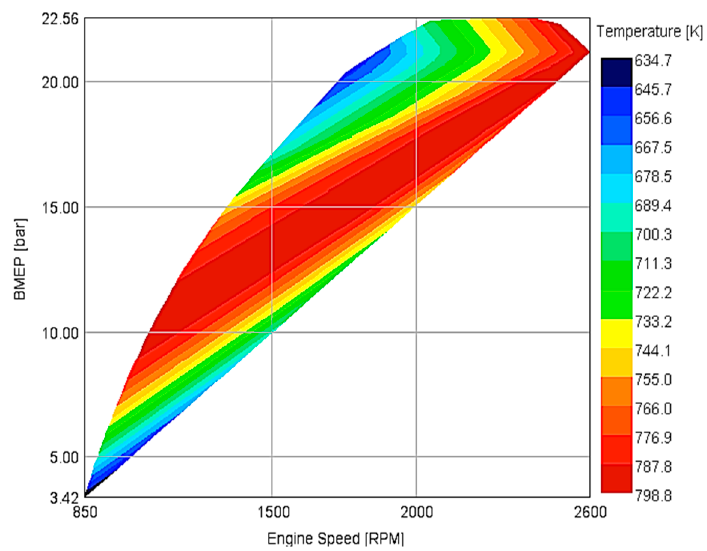
Figure 10. Variation of exhaust gas temperature in accordance with engines’ speed and BMEP.